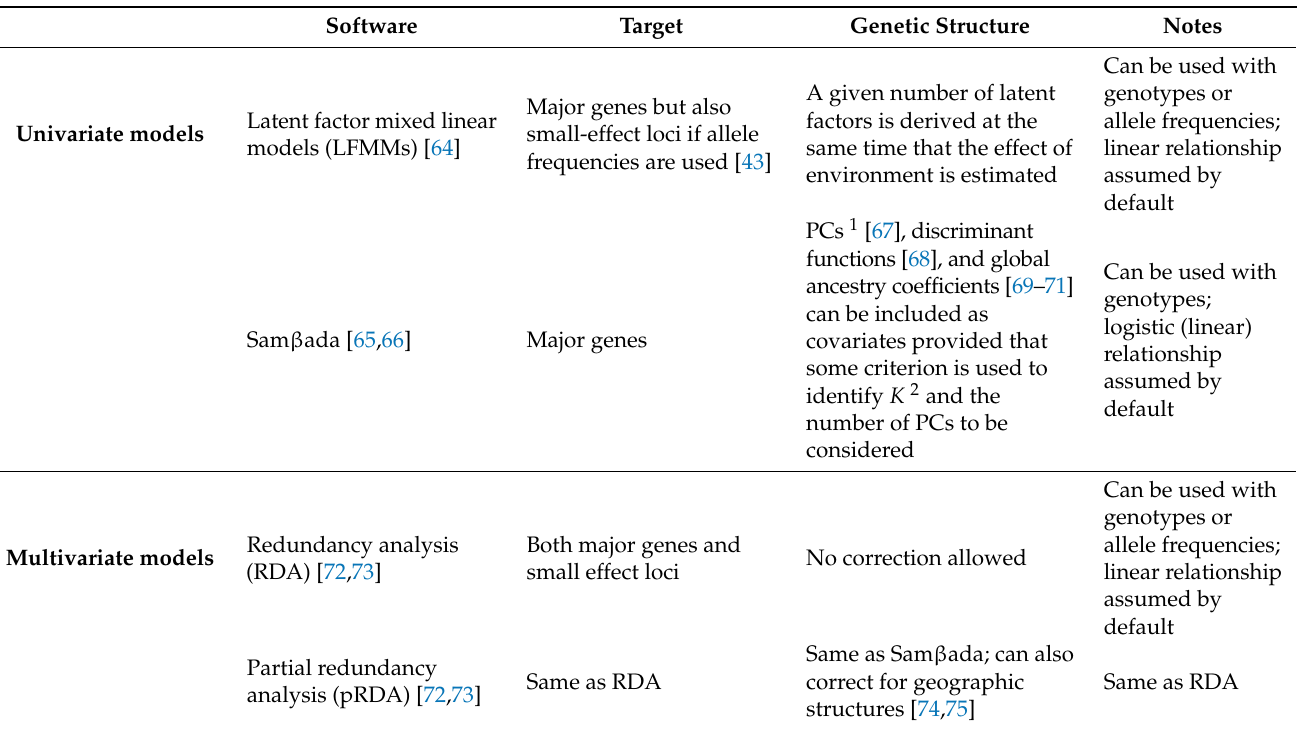
Table 1. A short list of uni- and multi-variate models in landscape genomics. ‘Genetic structure’ refers to the possibility of correcting for the confounding due genetic population structure in the association models. For an extensive review of the methods, we invite the reader to refer to Rellstab et al.